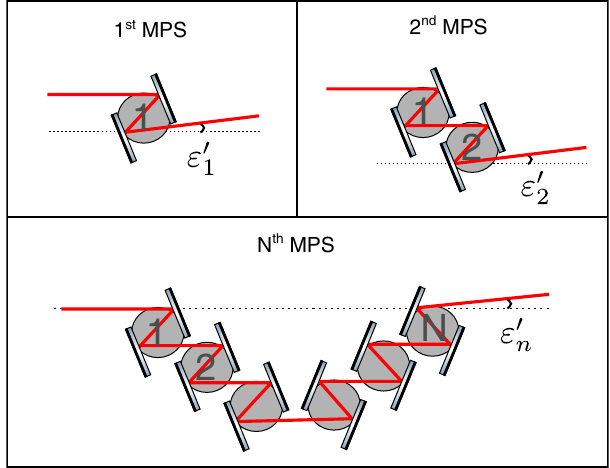
FIG. 8. Illustration of the MPS alignment for parallelism. The equations that describe this method are presented in Appendix B.